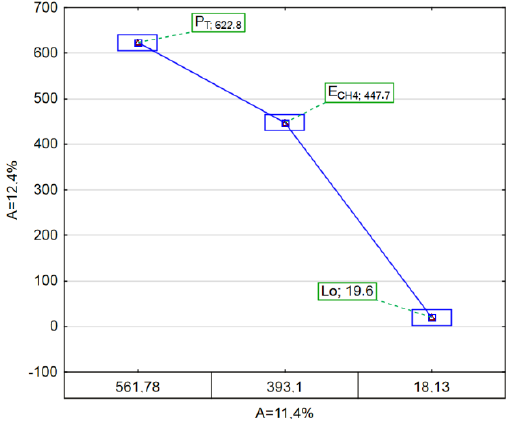
Figure 6. Dependence of modeling results on component A.